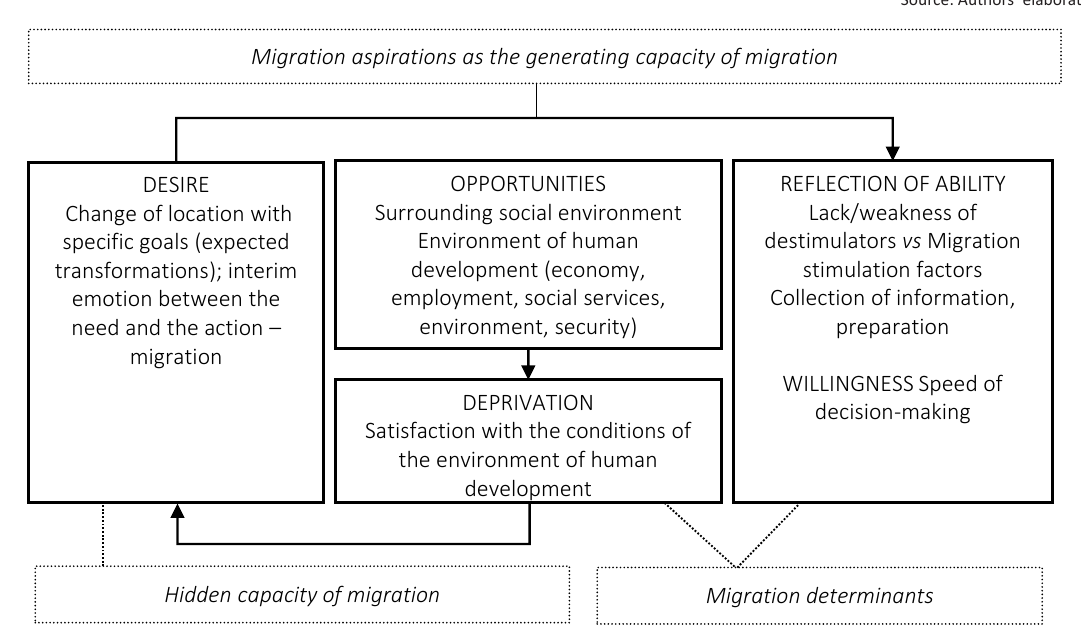
Figure 5. Psychological-behavioral vision of migration